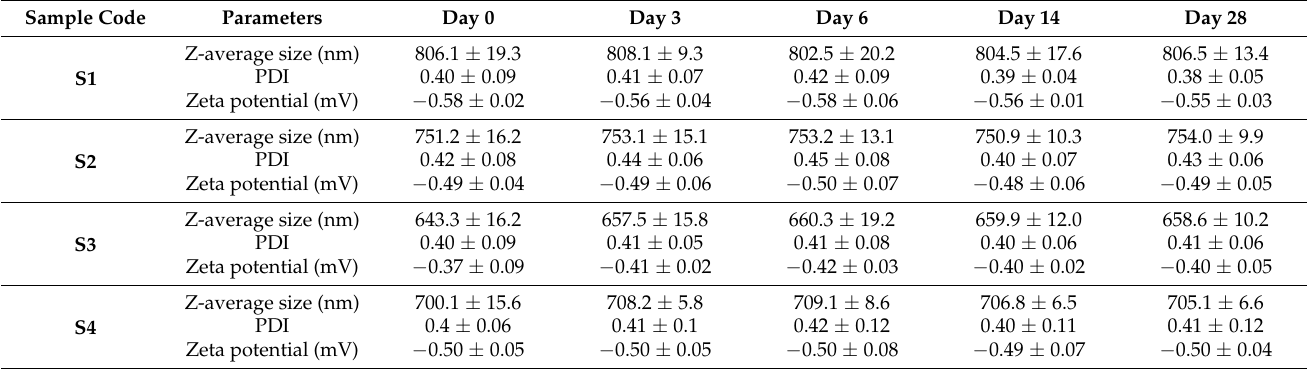
Table 2. The change of droplet zeta-average diameter and polydispersity index (PDI) of the formulated oil-in-water emulsions during storage. Data represent average values ± standard deviation of 10 replicates from each sample. There were no statistical differences during the storage ( p >